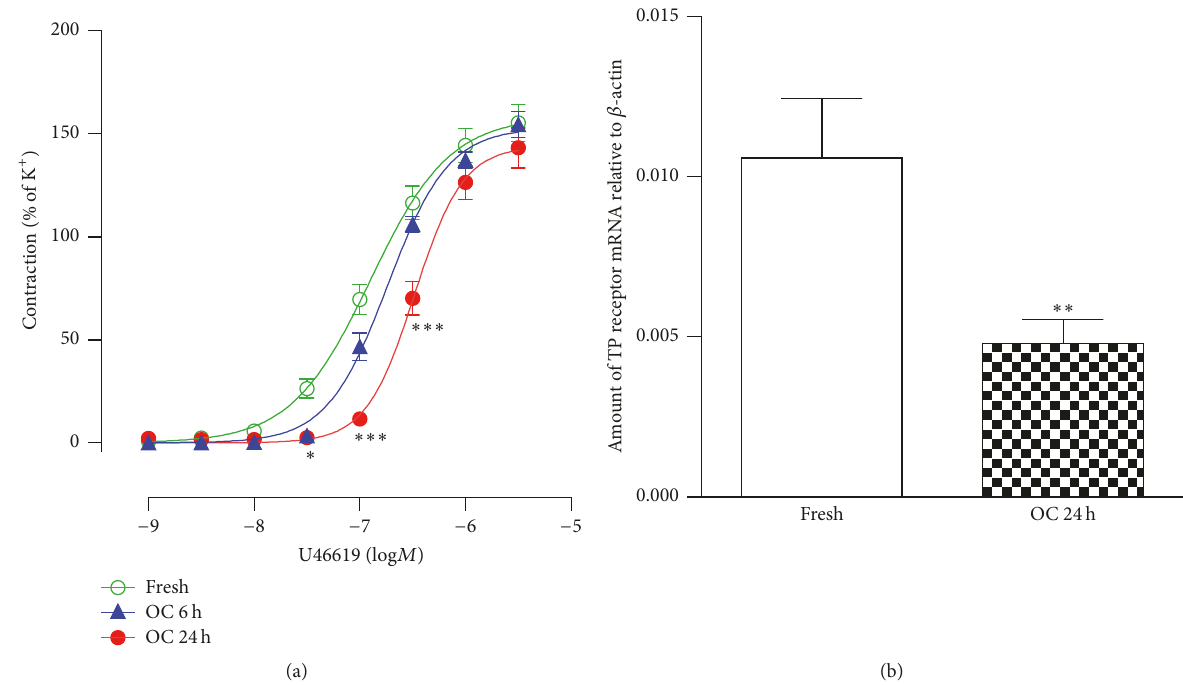
Figure 1: (a) Contractile responses to U46619 in the fresh segments or following organ culture for 6 or 24 h. Data are shown as means ± SEM ( 𝑛 = 8 –16). Two-way ANOVA with Bonferroni post test was used. ∗ 𝑃 < 0.05 , ∗∗∗ 𝑃 < 0.001 versus fresh. (b) TP receptor mRNA expression in fresh renal arterial segments or organ cultured for 24 h. Data are shown as means ± SEM ( 𝑛 = 6 –8). Unpaired Student’s 𝑡 -test was used. ∗∗ 𝑃 < 0.01 versus fresh. Fresh = noncultured segments; OC 6h = organ cultured for 6 h; OC 24 h = organ cultured for 24 h.